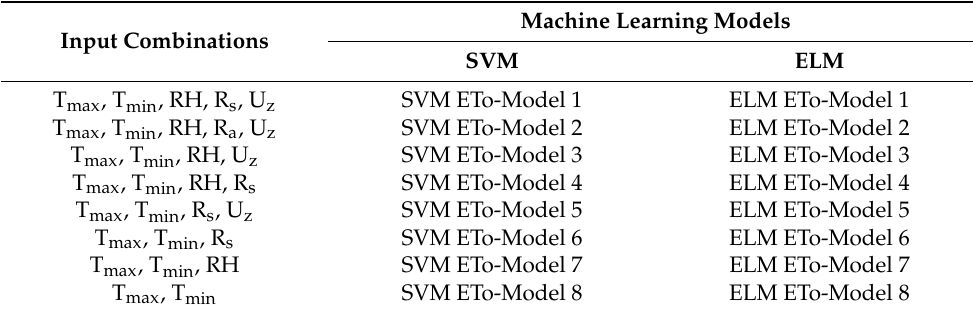
Table 3. The input combinations of meteorological variables used for the development of the SVM and ELM models for ETo